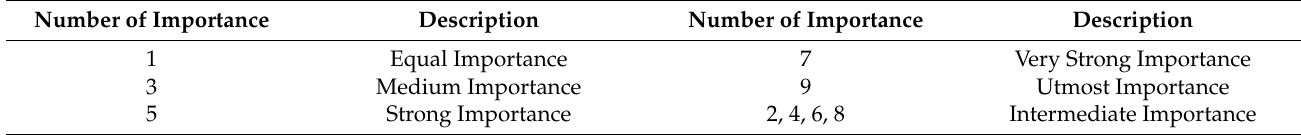
Table 2. Pairwise comparisons of AHP method.